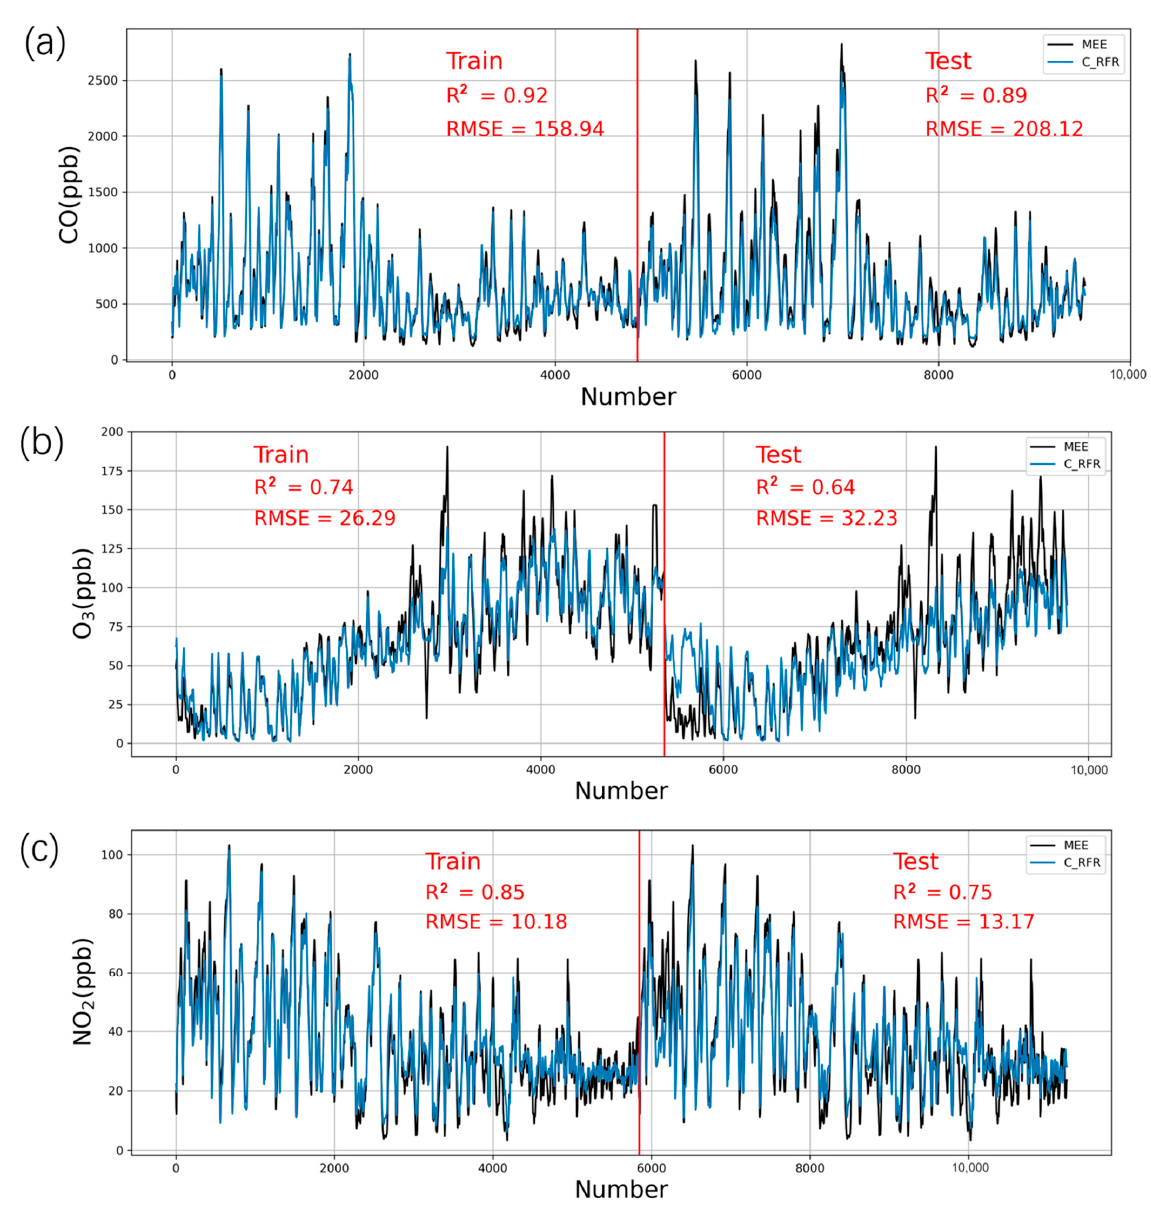
Figure 3. Training and testing of sensors using the random forest regressor (RFR) method and comparison with MEE data from the reference instruments based on a 24 h rolling average. ( a ) CO, ( b ) O 3 , and ( c ) NO 2 . One set of sensors in Model 1 is the training data, and the other set of sensors in Model 2 is the testing data.